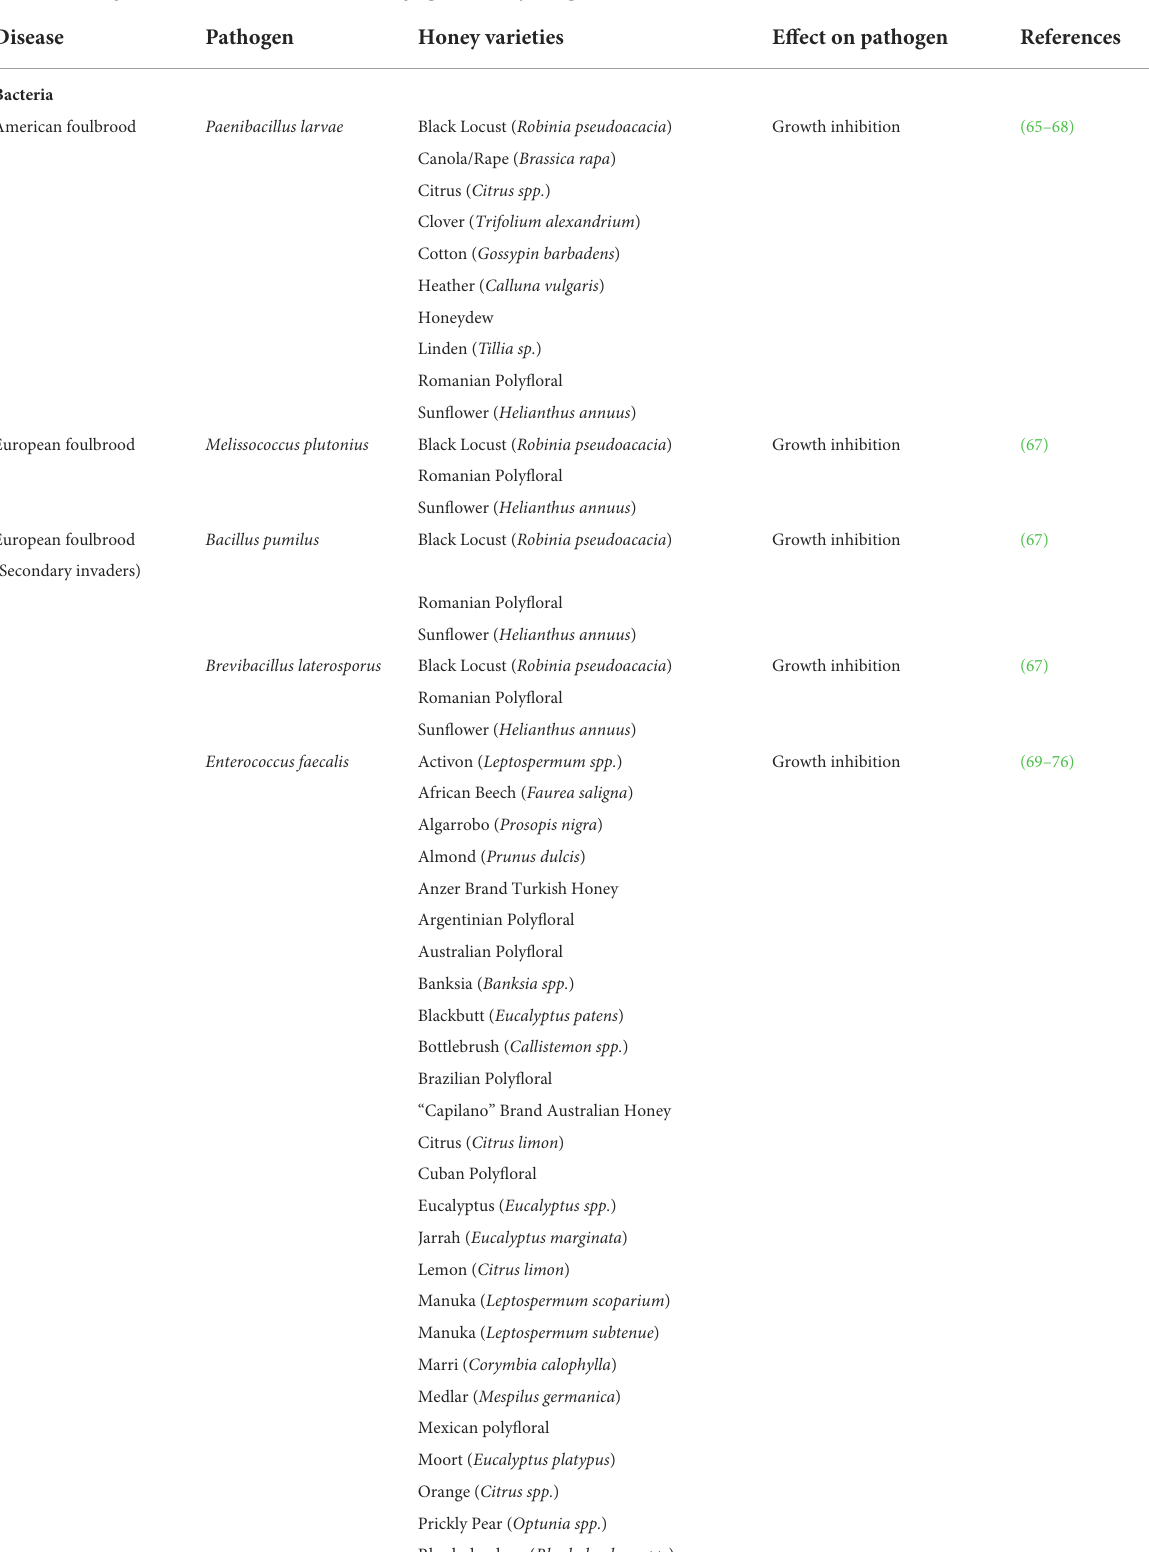
TABLE 2 Honey varieties with antimicrobial activity against hive